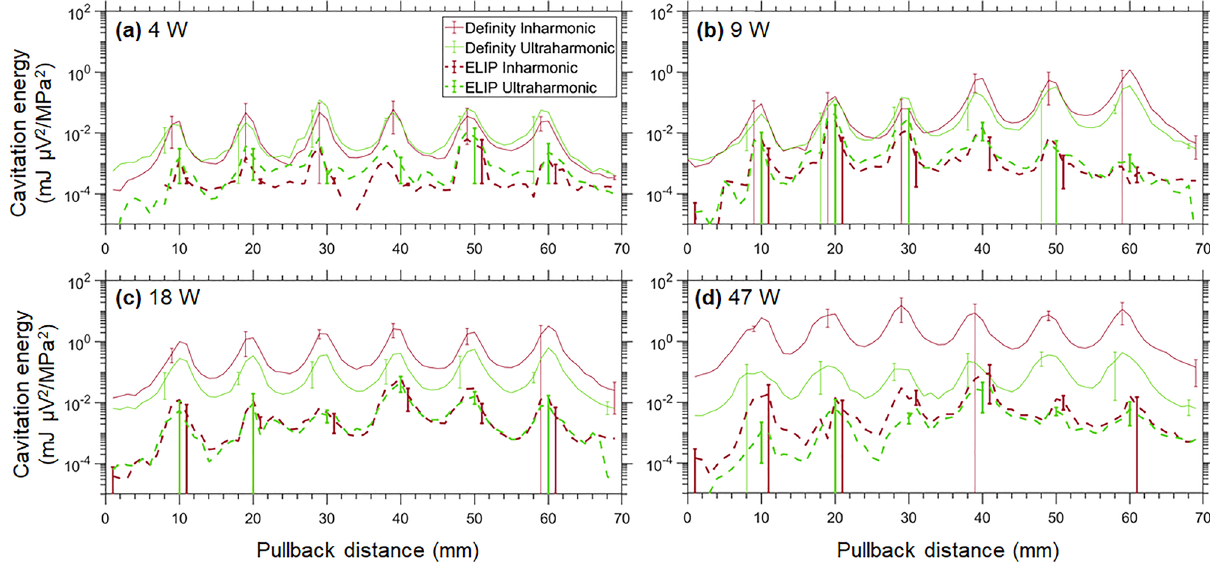
Figure 5. Cavitation energy along the active distal six transducer pairs of the EkoSonic catheter as OFP-PAFb- PGN-ELIP or Definity was infused. The mean ultraharmonic (green) and inharmonic (red) cavitation with electrical drive powers of ( a ) 4, ( b ) 9, ( c ) 18, and ( d ) 47 W. Note that the PCI post-processing protocol plots the ultraharmonic energy in excess of the inharmonic energy. Error bars represent ± 1 standard deviation, n = 3